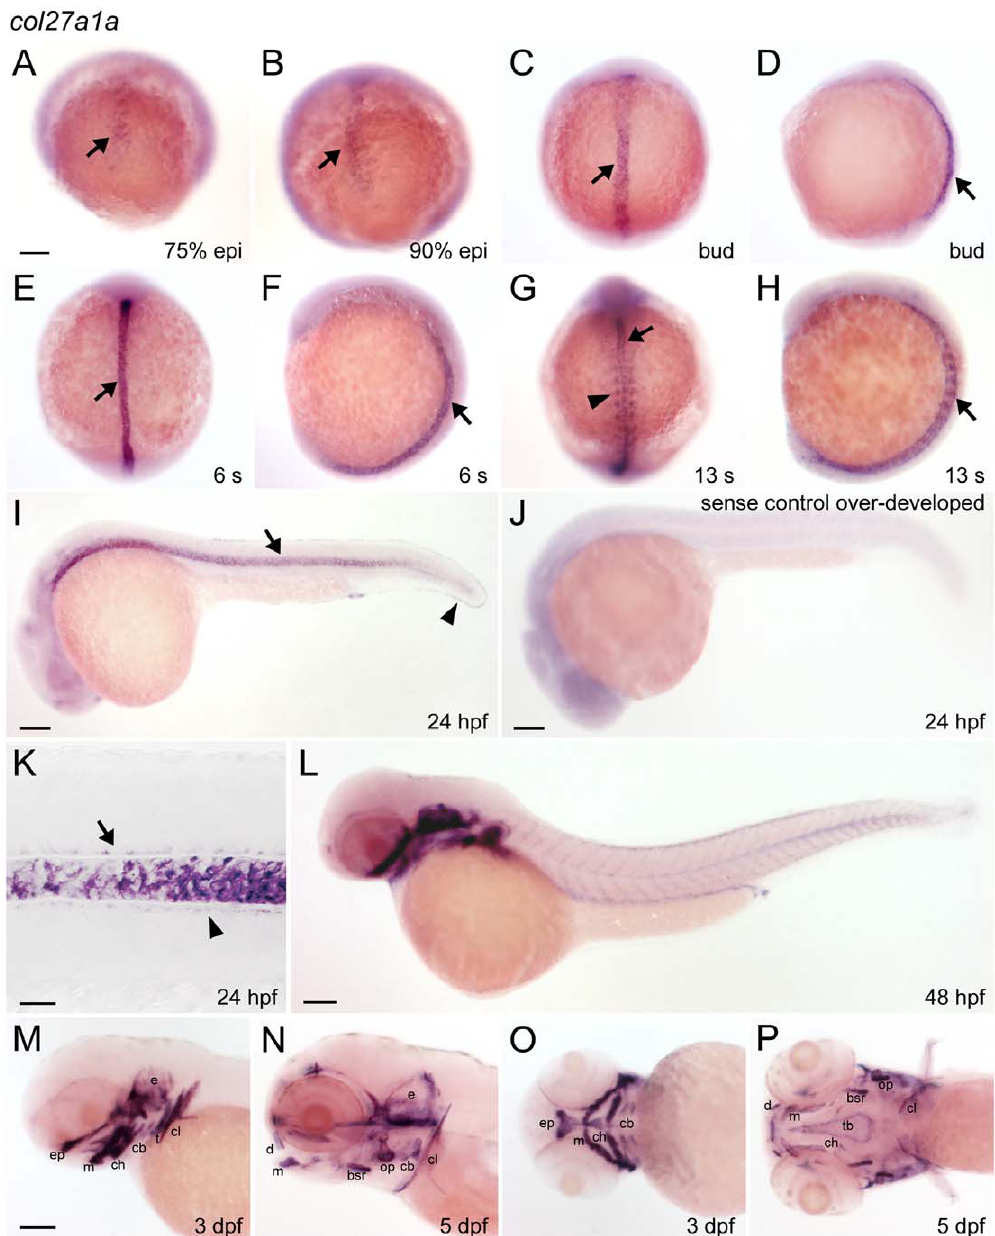
Figure 2. col27a1a is expressed in notochord and cartilage. (A–I) col27a1a was expressed in the notochord at early stages (black arrow), and (G) in the adaxial cells of the somites by 13 somite stage (arrowhead). At 24 hpf, expression was also observed in the (I) fin fold (black arrowhead) and in the (K) floor plate (black arrow) and hypochord (black arrowhead), surrounding the notochord. (J) Sense probe control was intentionally overexposed and revealed an absence of notochord staining. (L–P) Beginning at 48 hpf, strong expression of col27a1a was seen in the cartilage elements of the head and continued through 5 dpf, the latest time point analyzed. (M) Expression was also seen in the first forming tooth. Scale bar in K represents 20 m m. Scale bars in remaining images represent 100 m m. Scale bar in A applies to B–H. Scale bar in M applies to N–P. bsr, branchiostegal ray; cb, ceratobranchial arches; ch, ceratohyal; cl, cleithrum; d, dentary; e, ear; ep, ethmoid plate; m, maxilla; op, operculum; s, somites; t, tooth; tb,